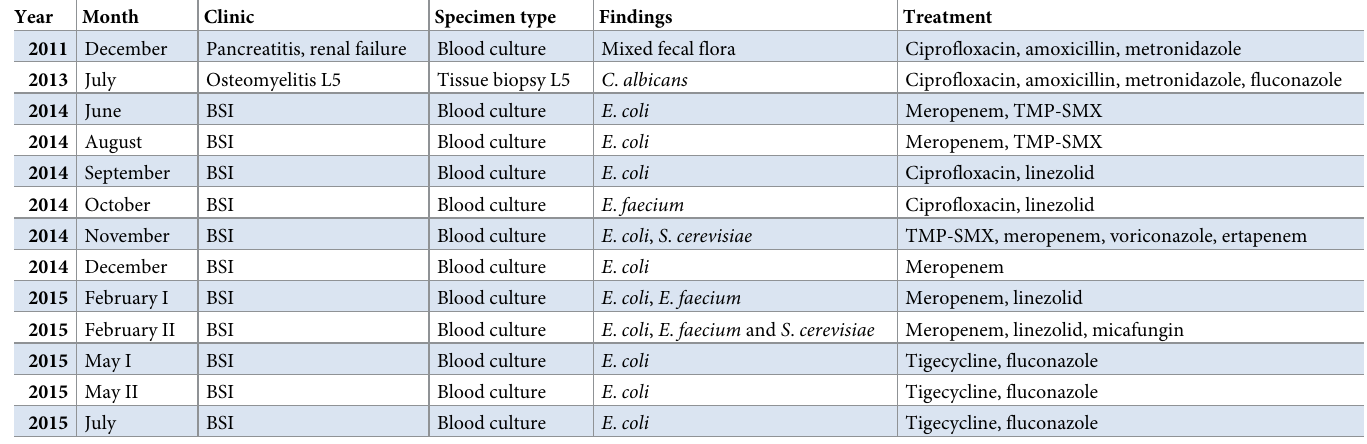
Table 1. Clinical and microbiological findings and antimicrobial treatment of